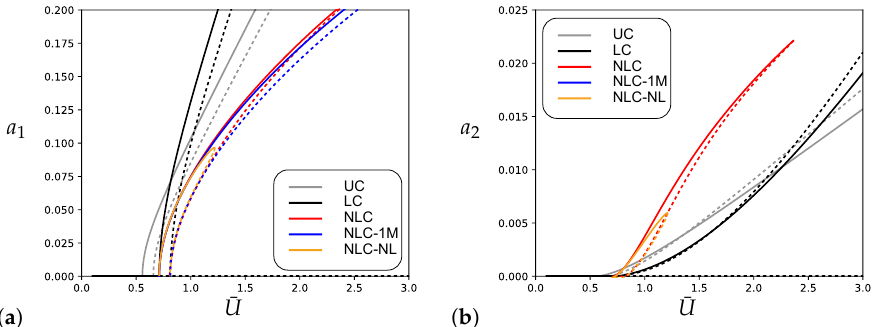
Figure 9. Bifurcation diagram for σ e = 0, σ i = − 0.06: ( a ) amplitude a 1 ; ( b ) amplitude a 2 (solid line: stable; dashed line: